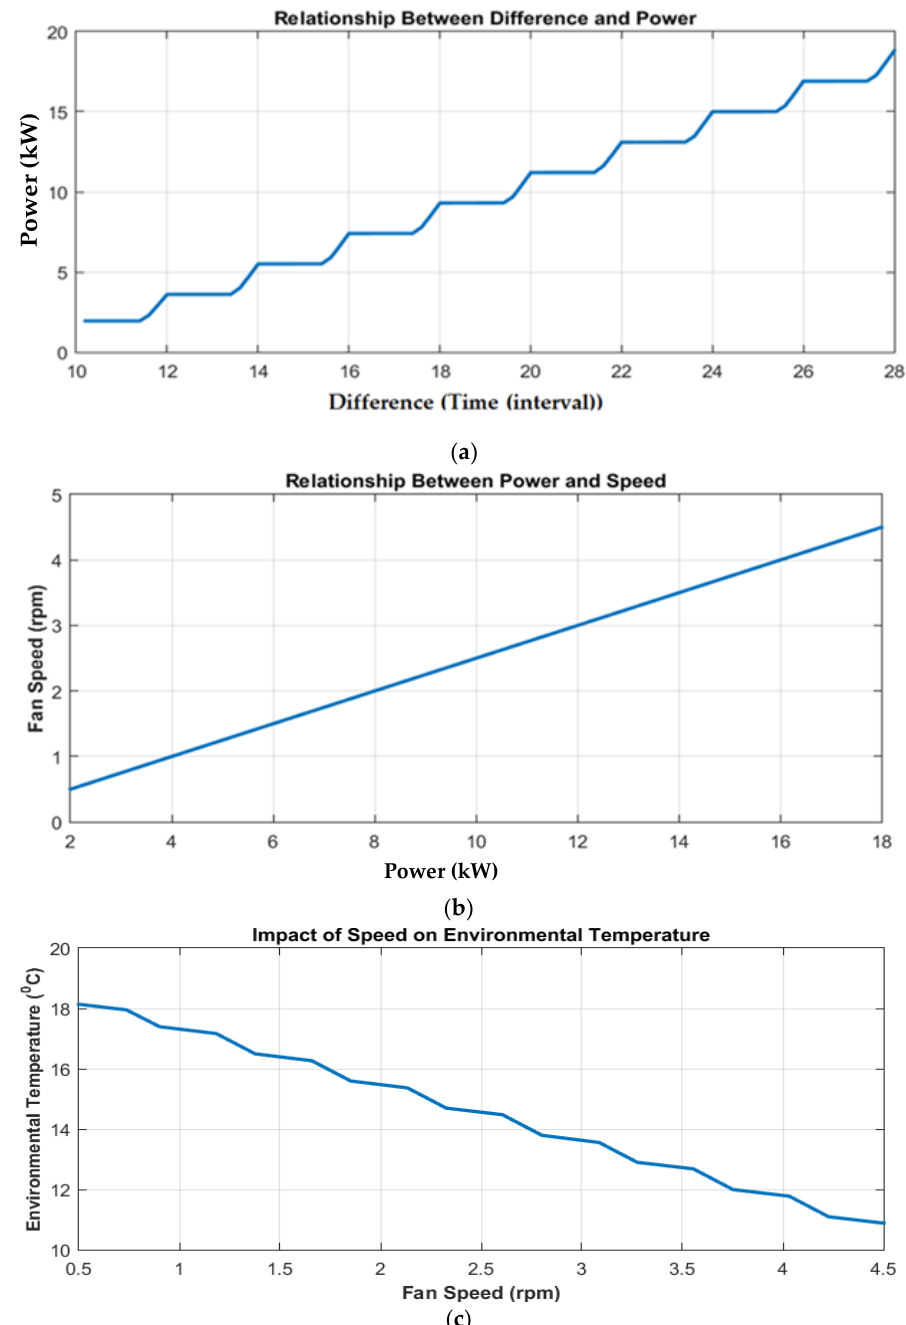
Figure 9. Relationship: difference between ( a ) current temperature and required temperature, ( b ) speed and power, and ( c ) speed and next temperature.